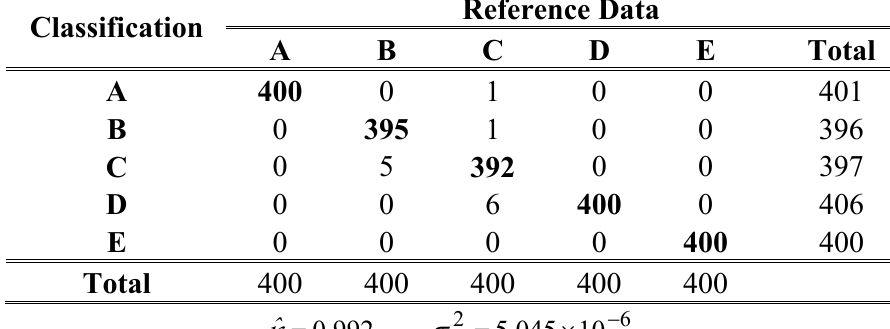
Table 7. Confusion matrix (# of pixels) using the bivariate HH-VV distribution